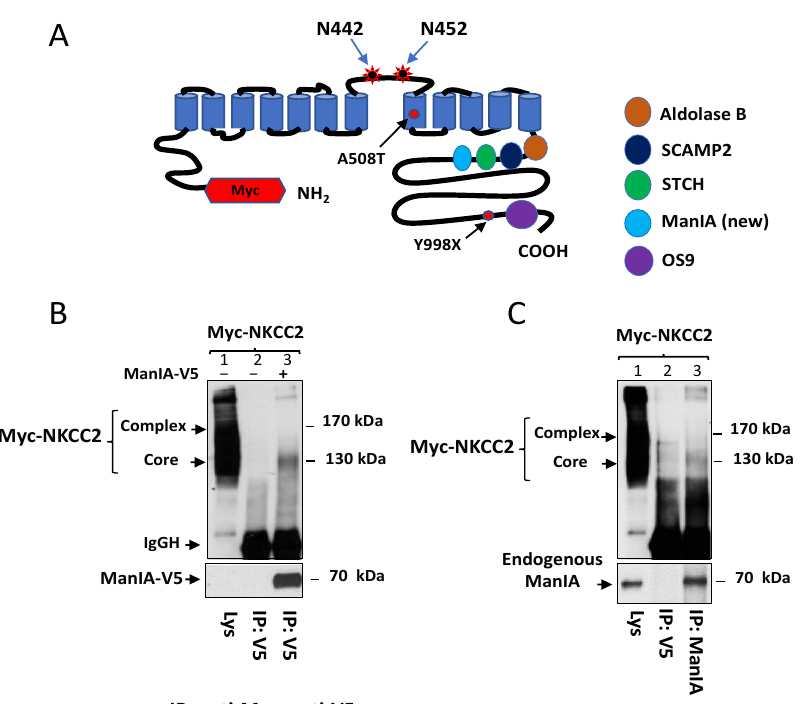
Figure 1. Identification of ManIA as a novel NKCC2-interacting protein. ( A ) A proposed topology for sodium-coupled chloride cotransporter NKCC2 N-terminally tagged with Myc. N442 and N452 are the potential N -glycosylation sites. NKCC2 mutations, A508T and Y998X, used in the present study are indicated by arrows and marked in rounds. We previously used mouse NKCC2 C terminus constructs as baits to screen a human kidney cDNA library using the yeast two-hybrid system. Similar to Aldolase B [51], SCAMP2 [52] and STCH [53], ManIA interact with the proximal region whereas OS9 binds to the distal region of NKCC2 C terminus [46]. ( B ) NKCC2 binds, in vivo, to ManIA in HEK cells. HEK cells transiently transfected with Myc-NKCC2 singly or in combination with ManIA-V5 were immunoprecipitated (IP) with anti-V5 anti-body ( lanes 2 and 3 ). 5 % of total cell lysate (Lys) was resolved as positive control. Co-immunoprecipitated NKCC2 and ManIA proteins were detected by immunoblotting (IB) using anti-Myc and anti-V5 respectively ( lane 3 ). IgGH, the heavy chain of IgG. The positions of immature (core glycosylated) and mature (complex-glycosylated) proteins of NKCC2 are indicated. The interaction of NKCC2 with ManIA implicates only the immature form of the cotransporter. ( C ) endogenous ManIA interacts with immature NKCC2. HEK cells overexpressing Myc-NKCC2 were immunoprecipitated ( IP ) with anti-V5 (negative control; lane 2 ), or anti-ManIA antibody from Sigma ( lane 3 ). Co-immunoprecipitated NKCC2 (only the immature form) was detected by immunoblotting ( IB ) using anti-Myc antibody ( lane 3